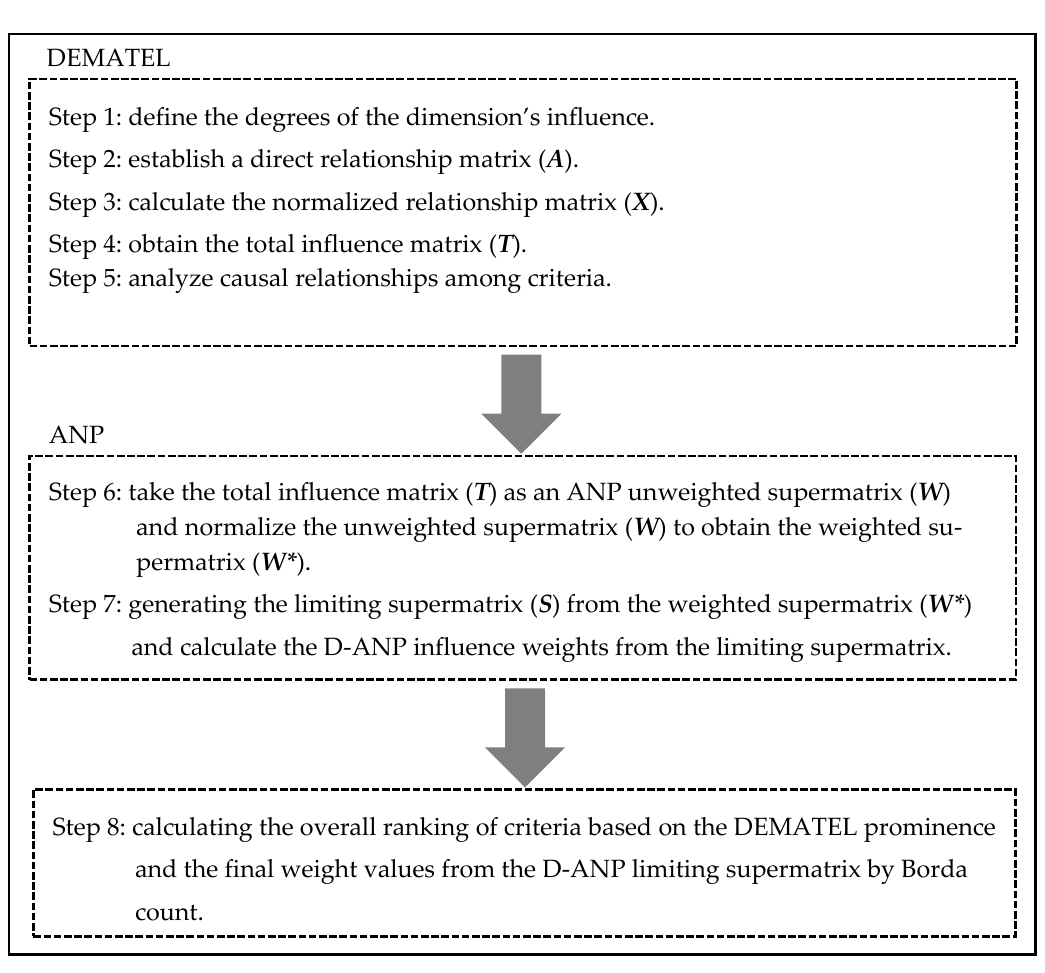
Figure 3. Calculation steps of the D-ANP (DEMATEL (Decision Making Trial and Evaluation Laboratory) based on ANP (Analytic Network Process)) method.